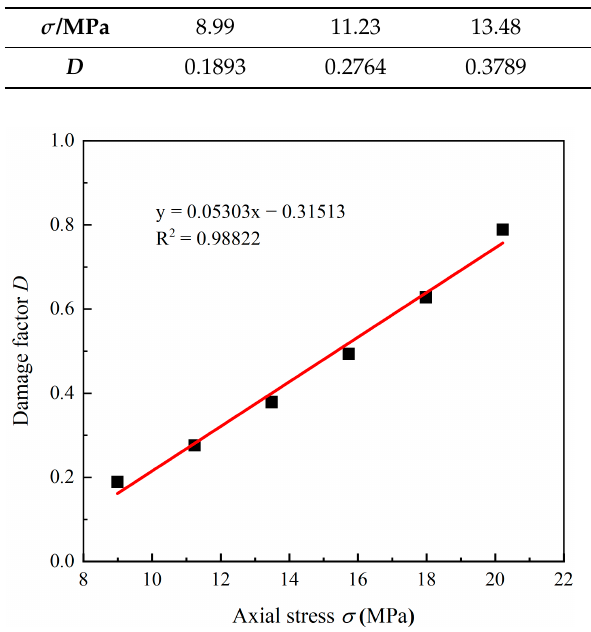
Table 2. Axial stress and the corresponding accumulated damage factor.